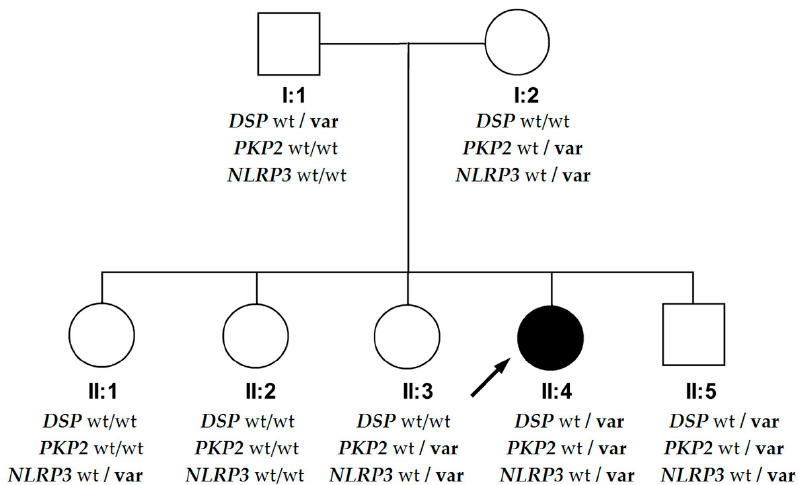
Figure 5. The results of genetic screening for the identified variants, shown on a pedigree. Squares